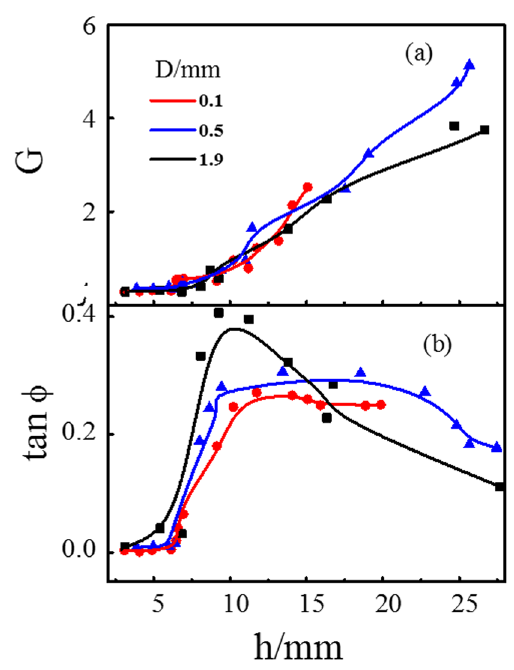
Fig. 4. (a) G and (b) tan ϕ of the glass beads systems with different particle diameters as a function of the immersed depth h , where the shear amplitude A = 4.45×10 -3